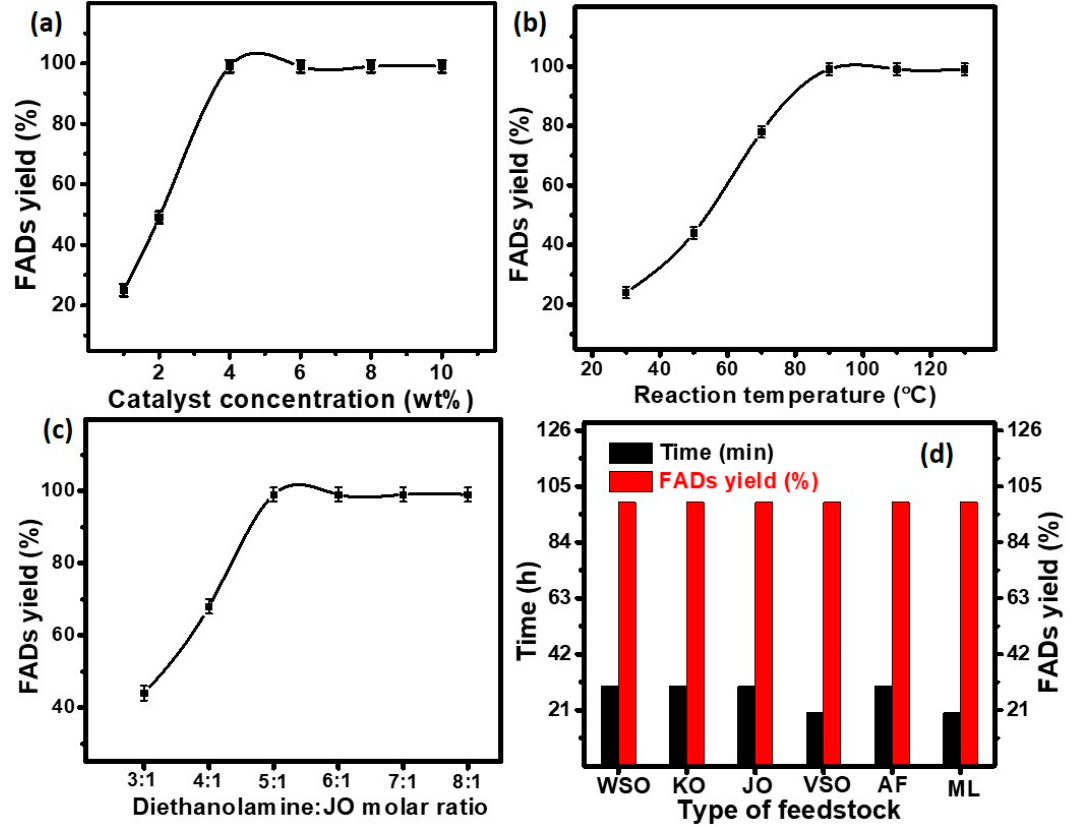
Figure 5. Effect of ( a ) catalyst concentration, ( b ) reaction temperature, and ( c ) the diethanolamine (DEA) / JO molar ratio on the complete aminolysis of used cotton seed oil (reaction time = 0.5 h). (d) The effect of different feedstock on the time required and the fatty acid diethanolamine (FAD) yield for the amidation reaction. Reaction conditions: diethanolamine/feedstock = 5:1 (m/m), catalyst amount = 4 wt % of feedstock, temperature = 90 °C.